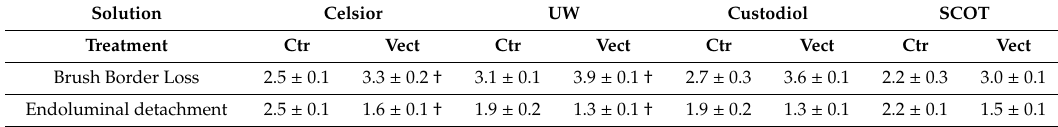
Figure 2. Evaluation of Vectisol ® benefits during static preservation: early follow-up. Vectisol was used to supplement preservation solutions in a porcine model of kidney autotransplantation, where solutions used were: ( A ) Celsior ® ; ( B ) University of Wisconsin ® (UW); ( C ) Custodiol ® ; and ( D ) Solution pour la Conservation des Organes en Transplantation (SCOT15 ® ). The benefits were evaluated over the first two weeks post-reperfusion. Shown are: Top : plasma creatinine, Bottom : sodium excretion. Graphical evolution over the first two weeks is displayed, and AUC (Area Under the Curve) comparison was used to determine the statistical di ff erence. Shown are each data point (empty dots), as well as mean ± SD (filled diamonds), statistics (Wilcoxon Test): † : p < 0.05 to Ctr. Table 1. Histological evaluation of kidney biopsies at Day